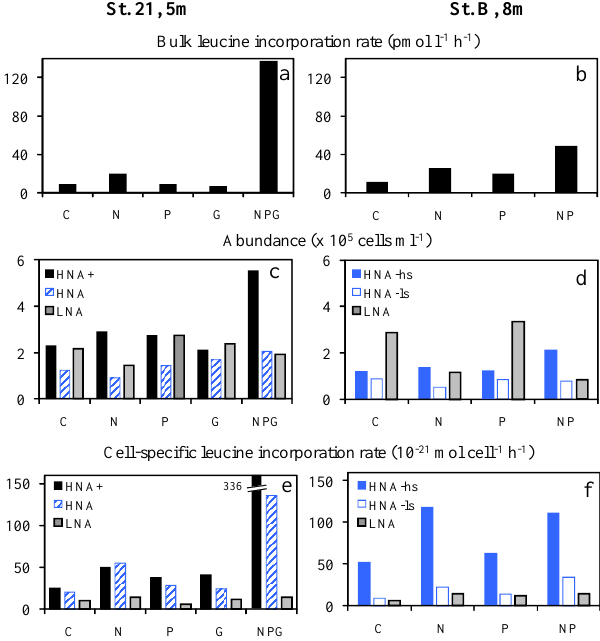
Fig. 8. Effects of enrichment experiments on: (a, b) bulk leucine incorporation rates, (c, d) abundances, (e, f) cell-specific leucine incorporation rates. Left: St. 21, 5m; Right: St. B, 8m. with the capability of harvesting light energy (Mary et al., 2008b). Finally, in P-deficient environments, LNA cells may have the advantage of growing and dividing more efficiently than other cells because their requirements for nucleic acid synthesis are by definition lower than that of HNA cells (lake study: Nishimura et al., 2005). Our enrichment experiments showed that LNA cells were also stimulated by preventing NP nutrient limitation, further proof of their